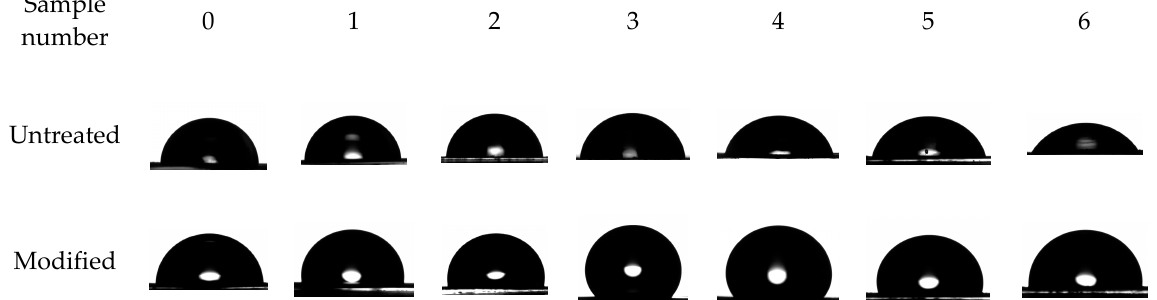
Figure 7. Water contact angles comparison of pictures of modified and untreated anodized alumi- num foil samples.